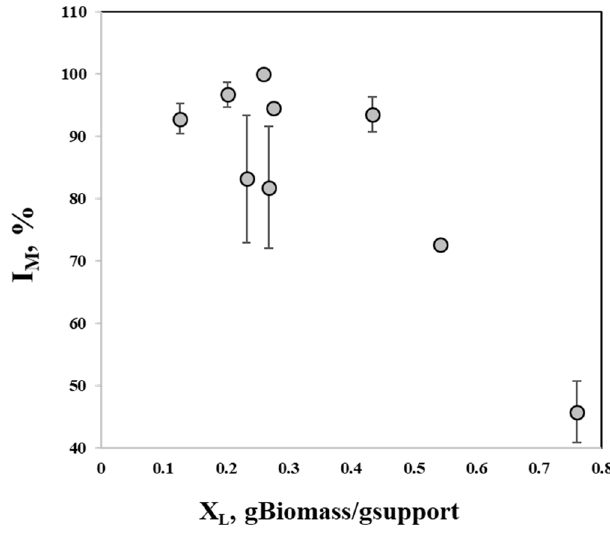
Figure 2. Biomass loading (X L , g Biomass /g support ) effect on immobilization capacity. Error bars depict the standard deviation between three replicates.